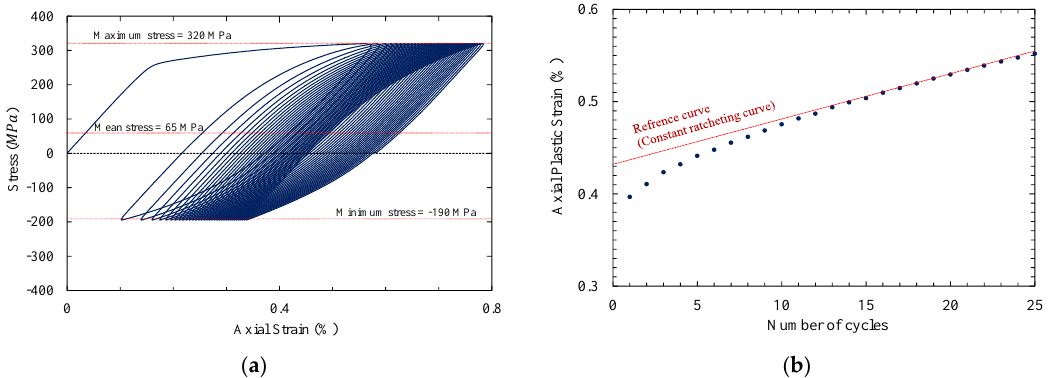
Figure 10. Experimental test data of ( a ) the uniaxial cyclic stress-strain response of AISI 316L SS under a stress-controlled condition ( b ) The plastic strain corresponding to the peak stress showing the rate of ratcheting of AISI 316L SS.